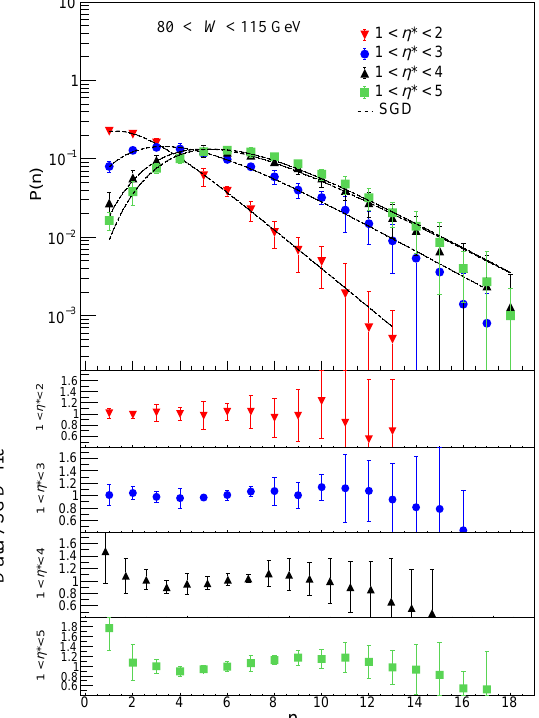
Figure 2. Multiplicity distributions for shifted Gompertz distribution (SGD), Equation (11), fits to the data [33] in different η ∗ ranges for 80 < W < 115 GeV. The lower panel shows the data/SGD-fit ratio plots for different η ∗ regions.